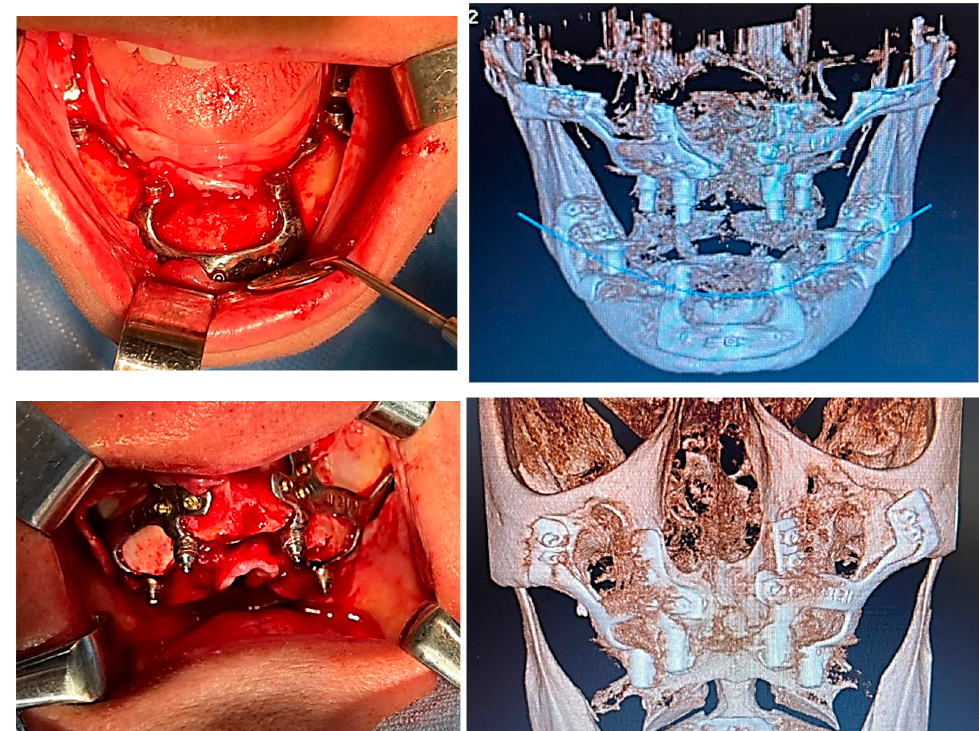
Figure 6. A patient with bimaxillary edentation treated with a subperiosteal implant in the maxillary and mandible (surgical stages and CBCT control after surgery).